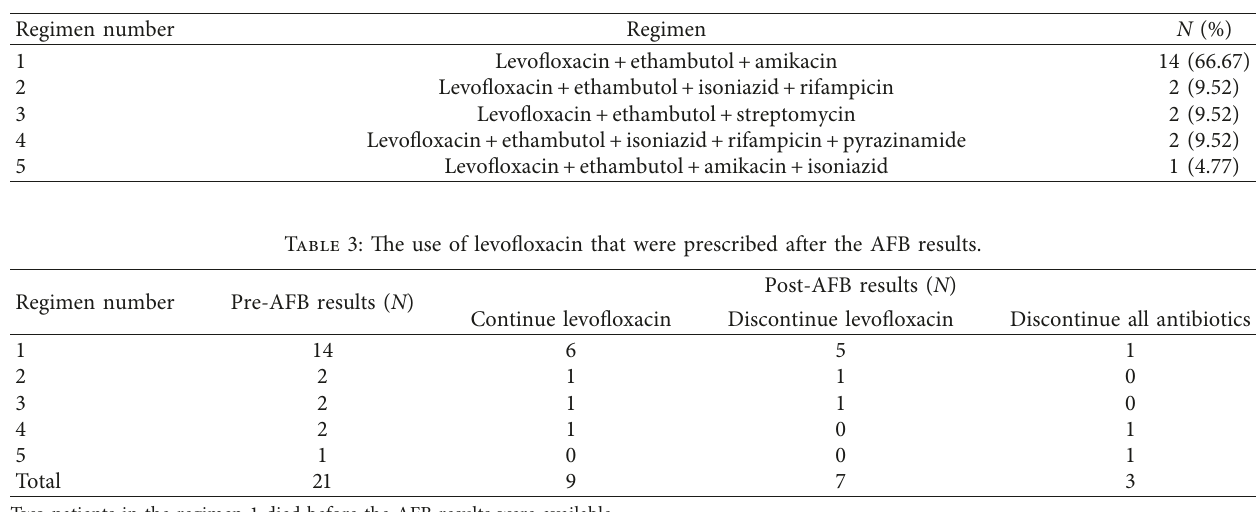
Two patients in the regimen 1 died before the AFB results were available. Table 4: Clinical data of 6 patients with chronic hepatitis and 2 patients who died before the availability of AFB results. Patient number Gender Number of AFB